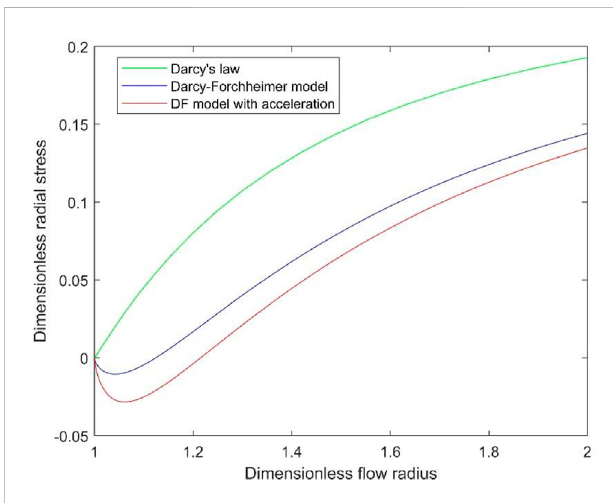
FIGURE 1 The effective radial stress distribution for the three fl ow